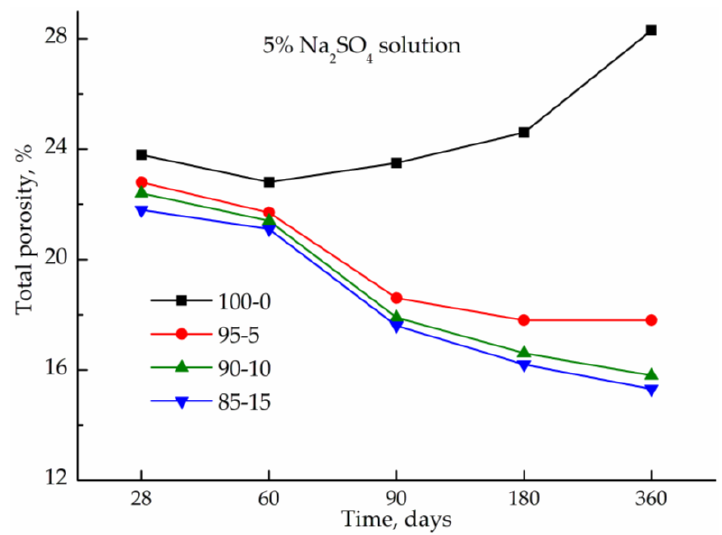
Figure 6. Total porosity of the mixed cement specimens hardened in 5% Na 2 SO 4 solution.